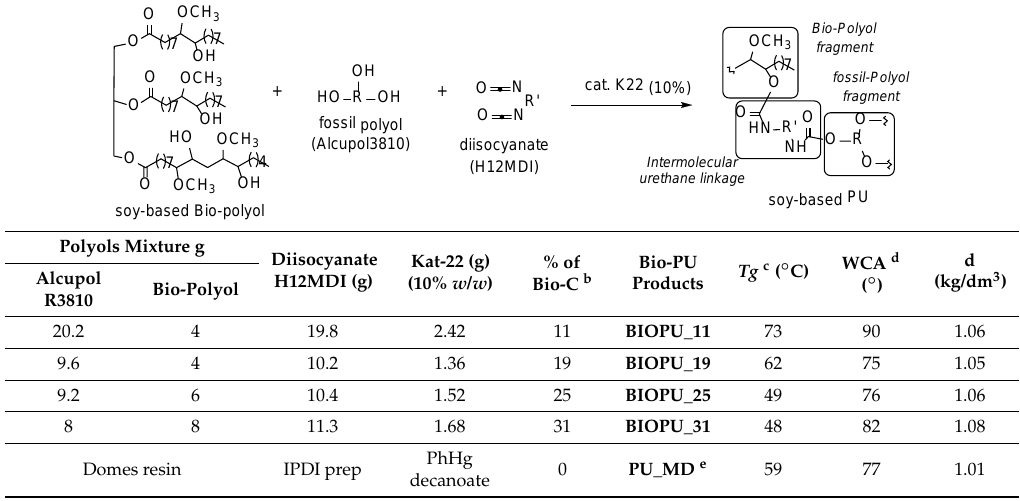
Table 3. Formulation of soy-based BIOPU_%C from PU_3810/K22/H12MDI a .